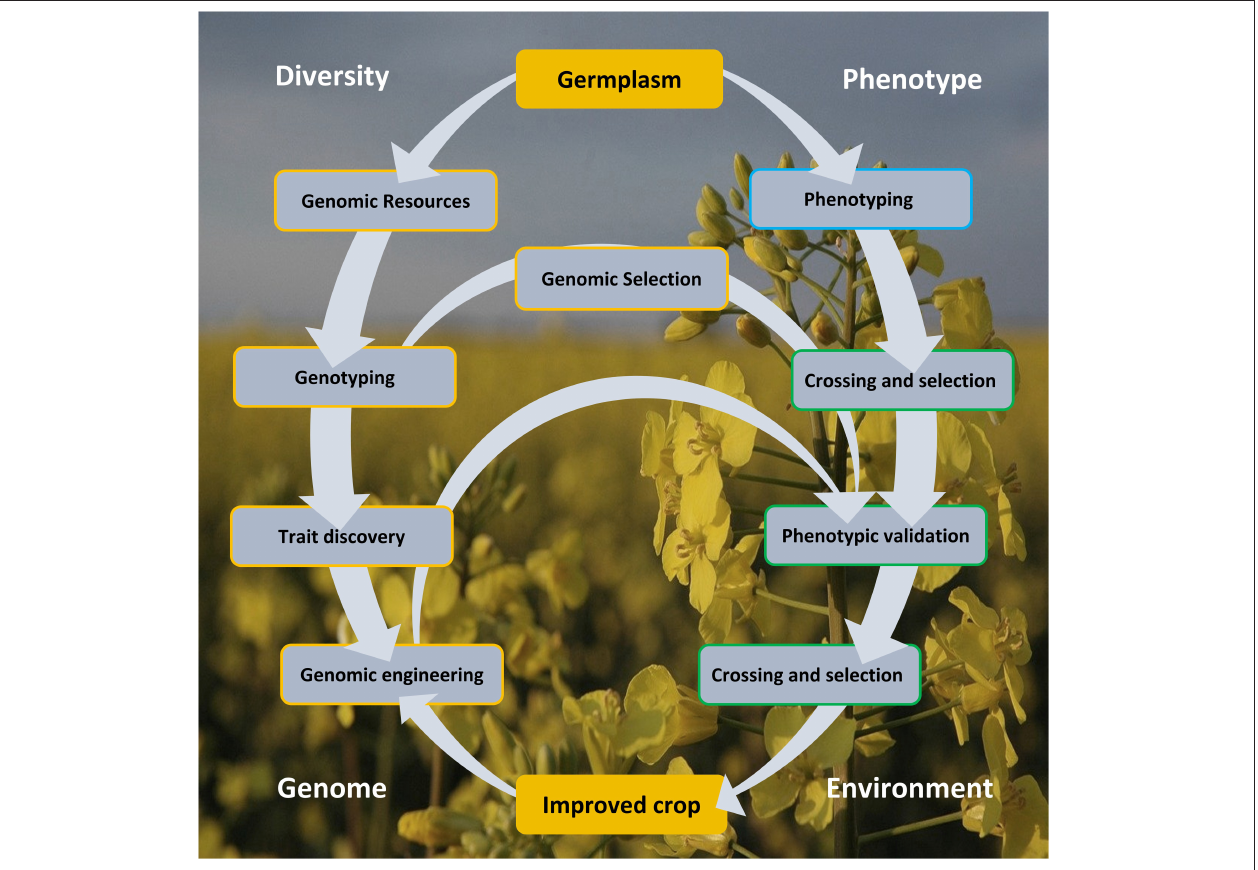
FIGURE 1 | The crop improvement cycle involves the exploitation of genomic diversity and phenotypic variability. These approaches offered a rapid and cost-effective lab-to-field and back loop, centered on arming the genomic arsenal by capitalizing on the variation in the germplasm resource, as defined in the genotype and from trait association. Genomic selection and engineering accelerated crop improvement, circumventing a more laborious and time-consuming conventional crossing and selection approach. Genomic engineering strategies also offer a more precise manipulation for improved crop development. The improved crop must be climate resilient and adaptive to the extreme environmental